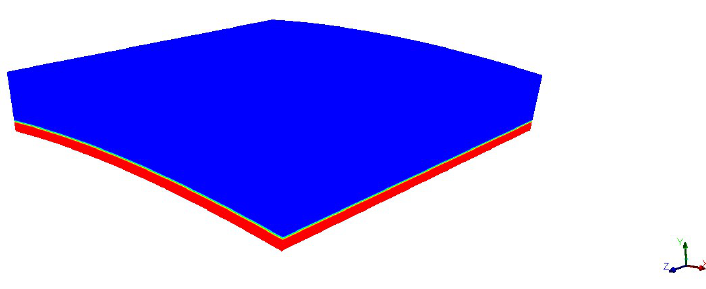
Figure 6. The phase distribution of the initial domain in the 3D model.